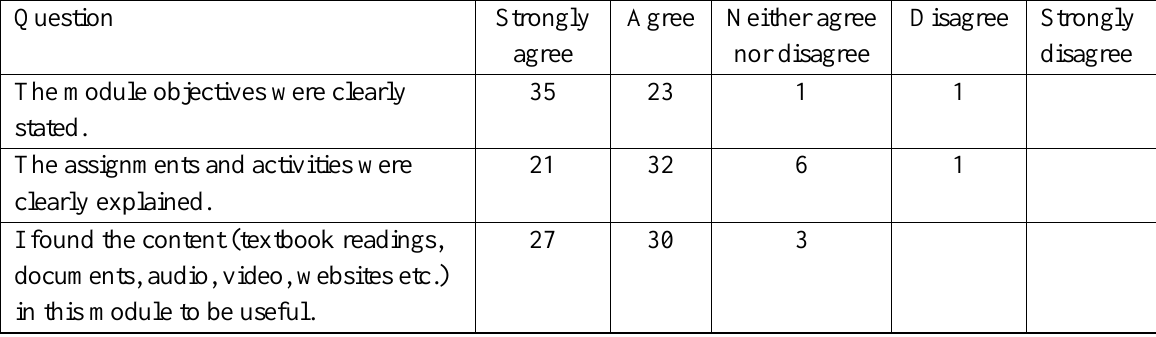
Responses from the Four Module Surveys for the Three Questions Repeated across Surveys